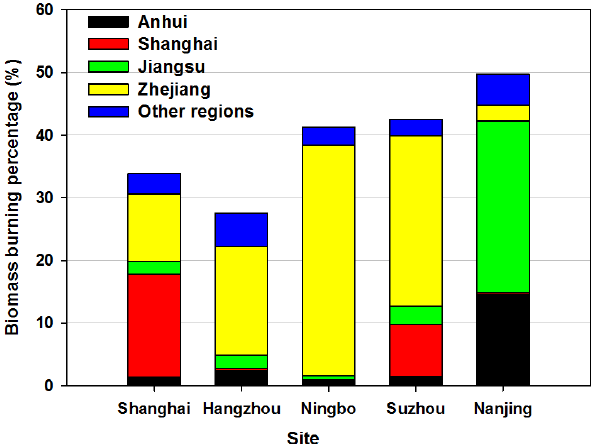
Fig. 9. Percentage contribution of biomass burning to PM 2.5 mass concentration. Location of each region is shown in Fig. 1. The remaining percentage represents the contribution of other emission sources.